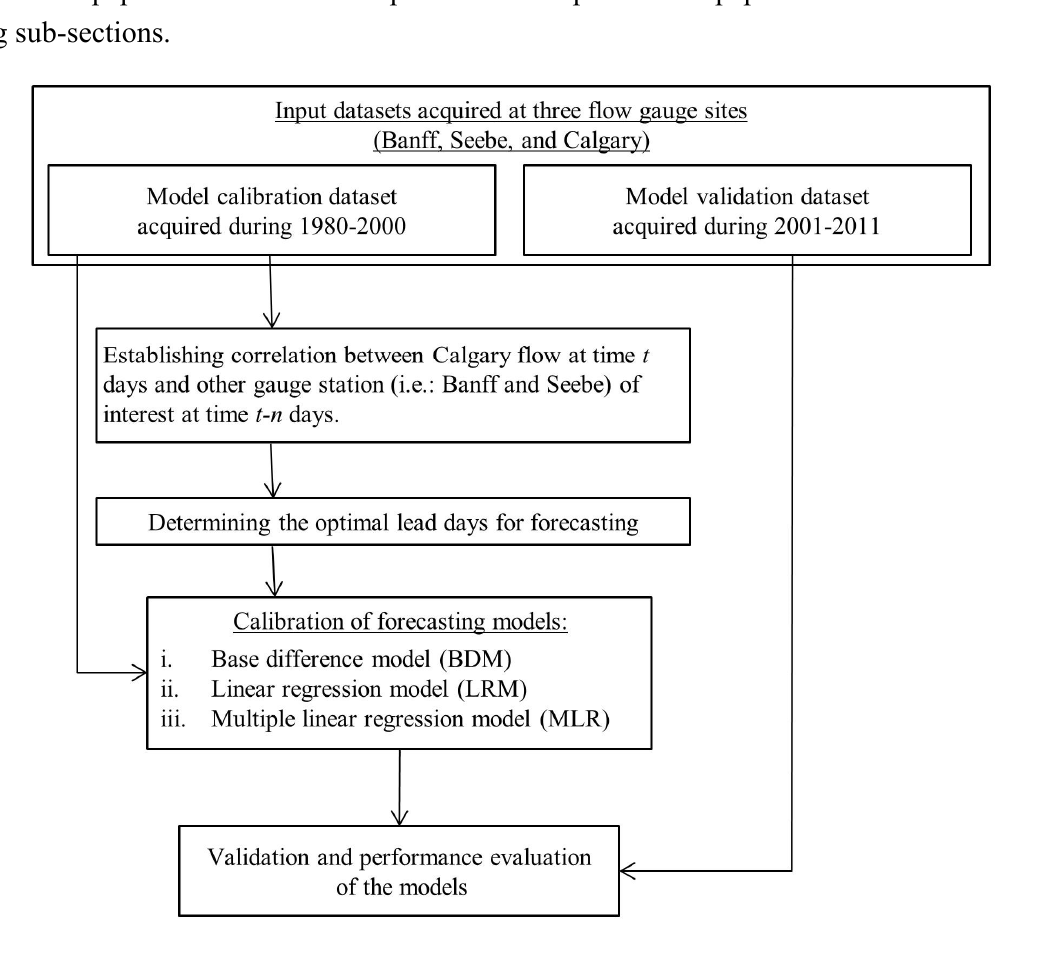
Figure 2. Schematic diagram of the methods used in this